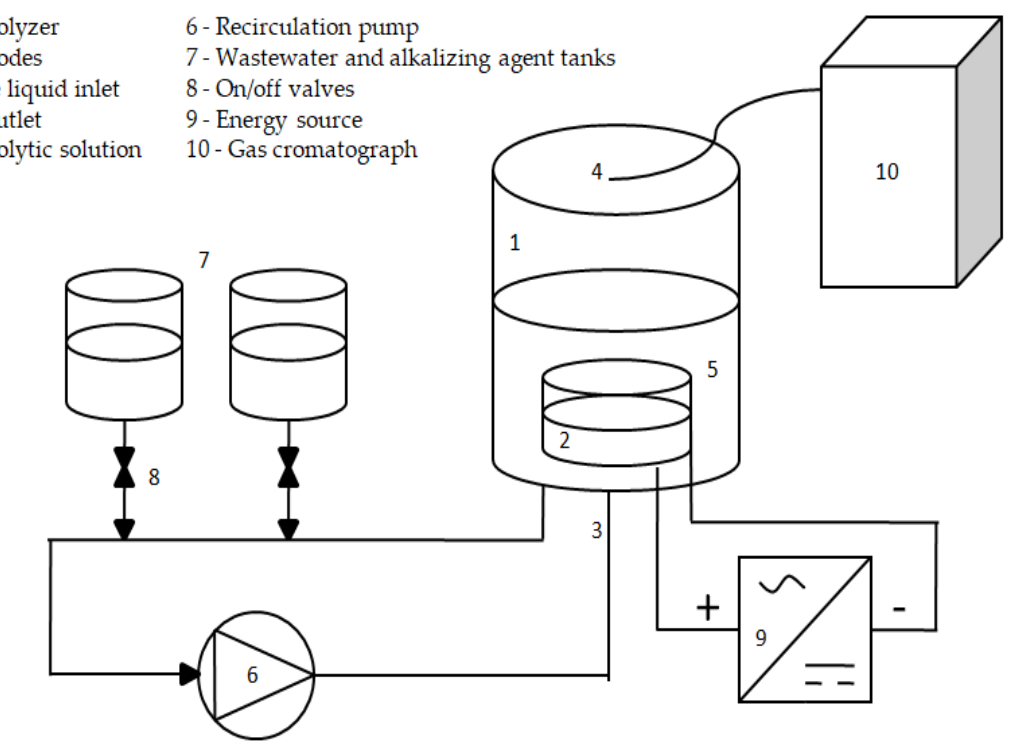
Figure 3. Electrolyzer and auxiliary